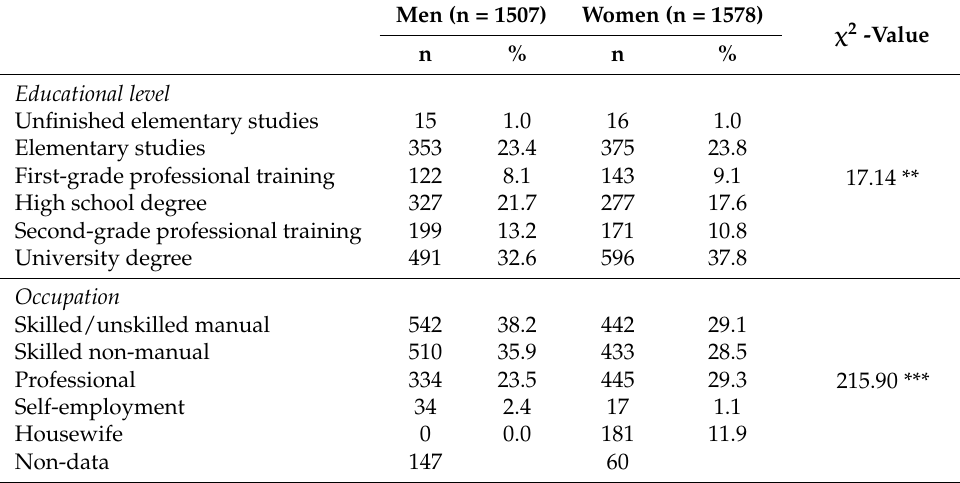
Table 1. Demographic characteristics of men and